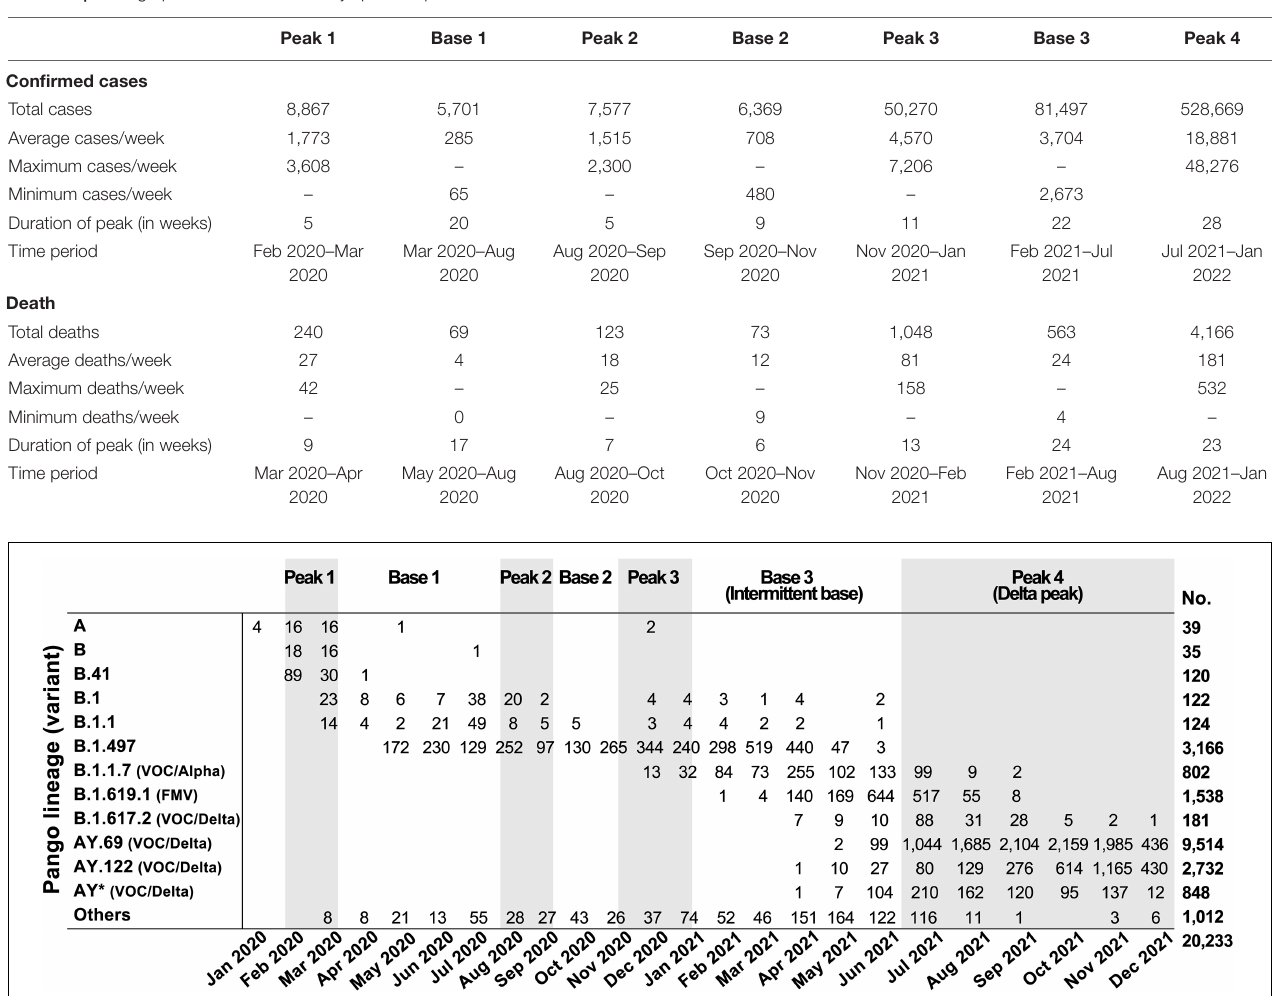
TABLE 1 | Demographics of SARS-CoV-2 by specified periods.